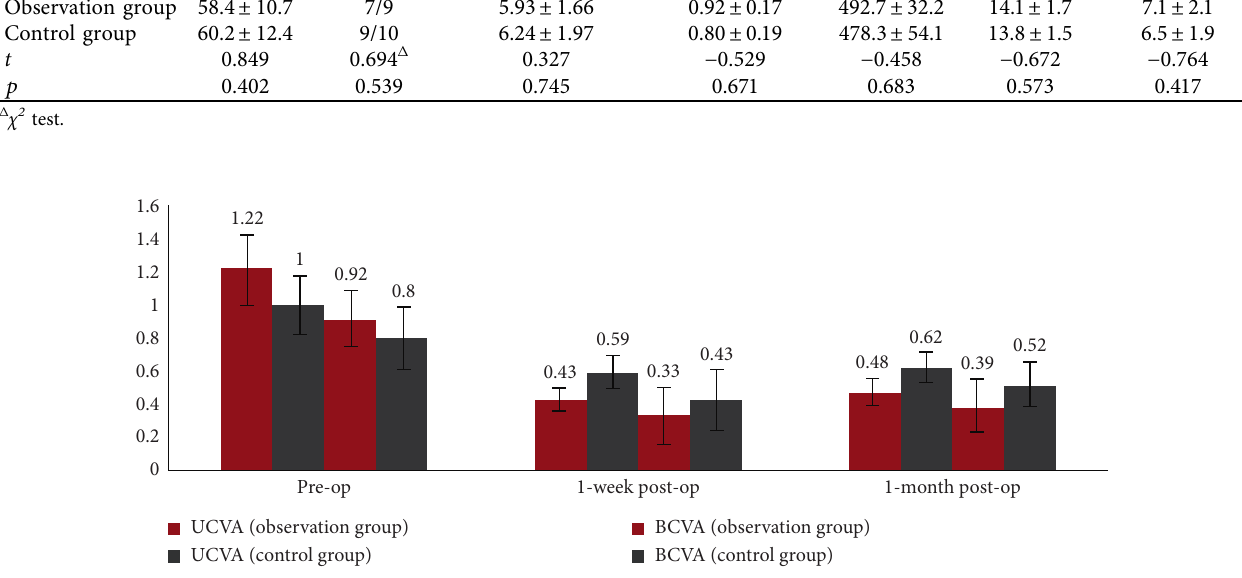
Figure 1: The trend of UCVA and BCVA at different time points in the observation group and control group. Table 2: Comparison of UCVA and BCVA at different time points between the observation group and control group. UCVA BCVA